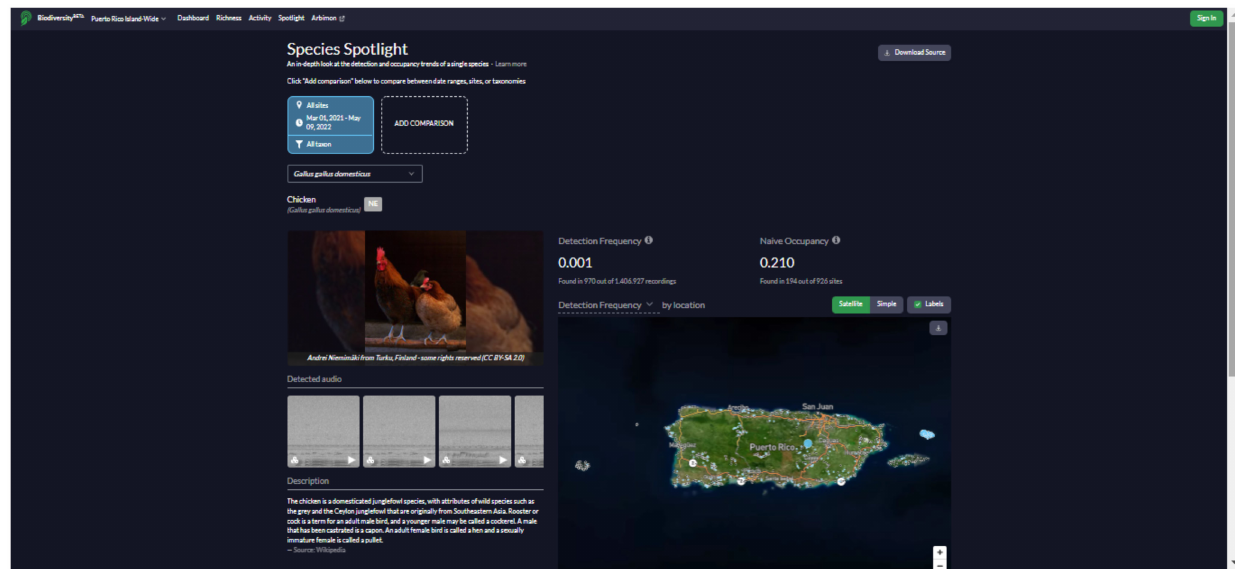
Figure A22. Spotlight: This page offers an in-depth look at the raw detection and occupancy of individual species. On this page, the user can select the species that were detected in the project data using either the scientific or common name. Basic information about the species, photo, call example, population status according to IUCN, detection frequency, and naive occupancy values are presented. The first map shows the detection results by site and allows for filtering by detection frequency, the number of detections (raw), and naive occupancy (i.e., proportion of occupied sites). A second map, when available for the species, shows the predicted occupancy (i.e., probability of occupancy) in Puerto Rico. In addition, a graph displays either detection frequency or the number of detections results according to the hour, day of the week, or month. Like the Richness and Activity pages, the data set can be subset by selecting one or more sampling sites or sampling periods.